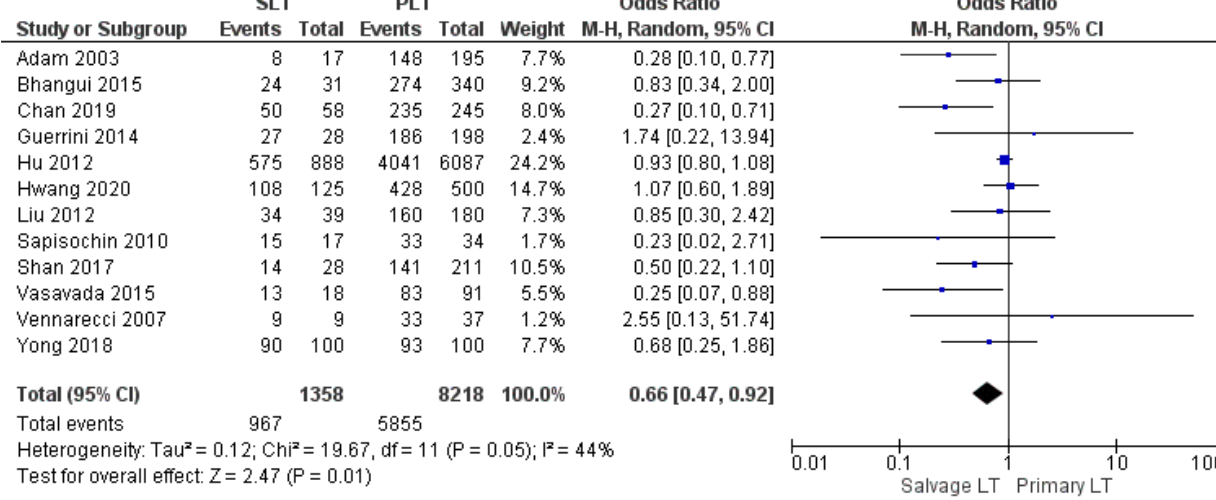
Figure 20. 1 - year disease free survival rates.